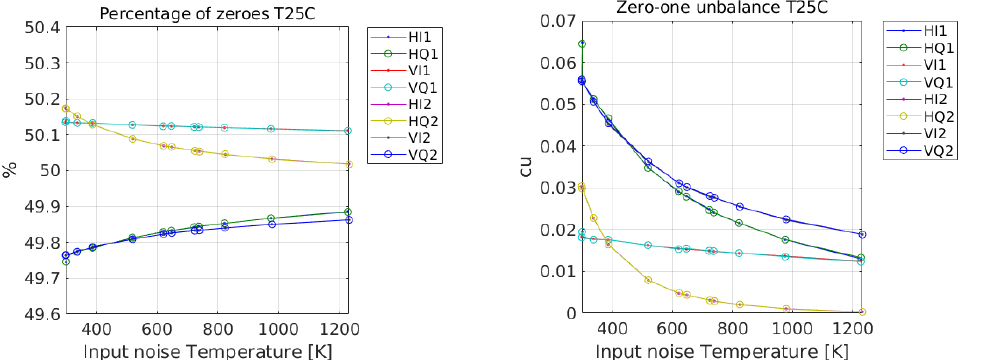
Figure 7. Percentage of zeroes and estimated samplers offset as a function of the total noise tempera- ture at the